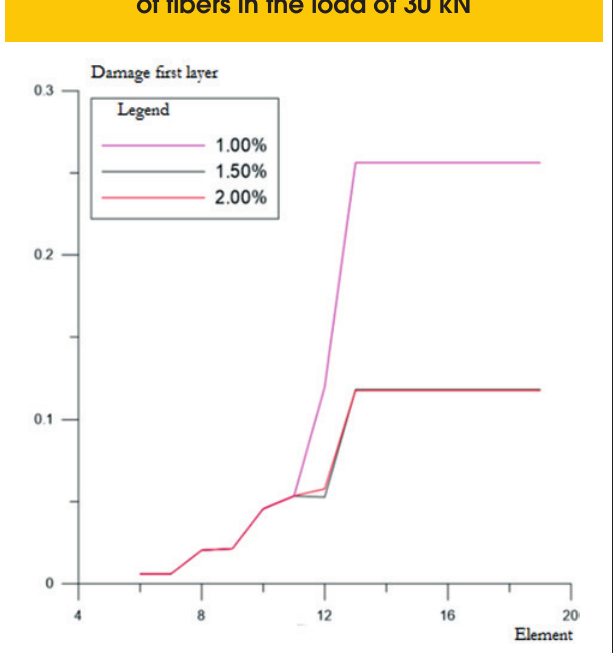
Figure 8 – Evolution of damage in the 1º tensileed layer in function of the percentage of fibers in the load of 30 kN